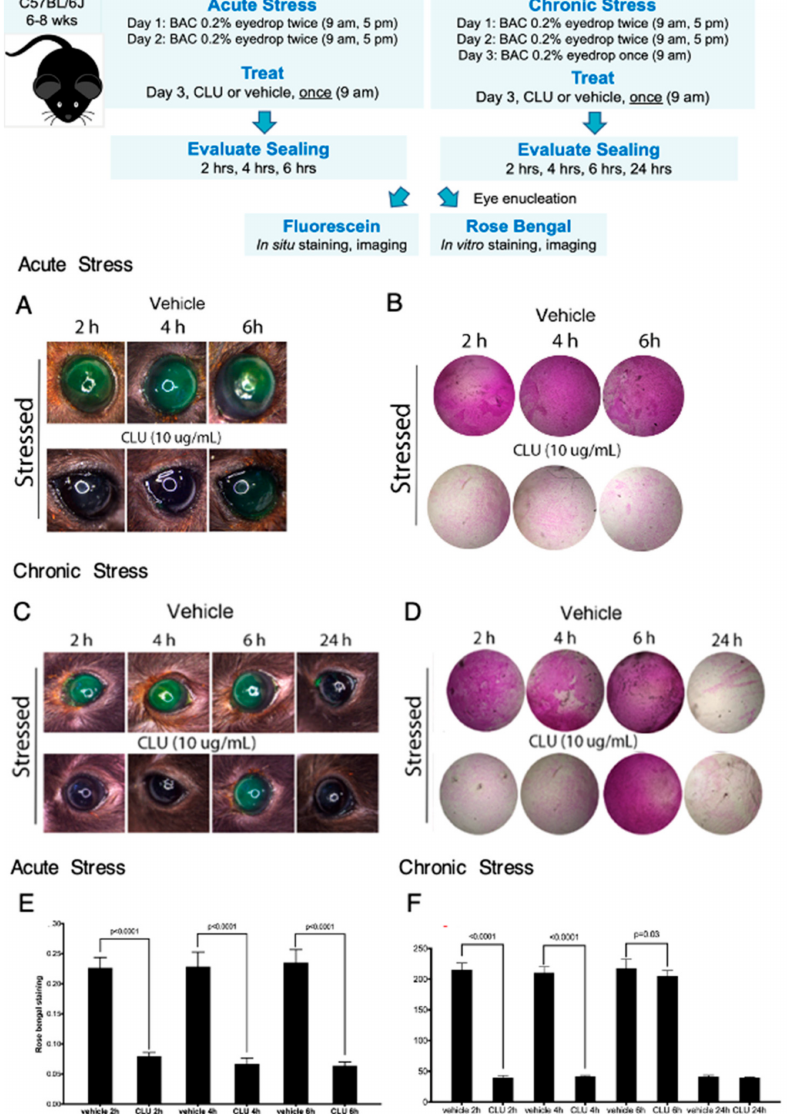
Figure 3. CLU sealing of the ocular surface barrier damaged by BAC persists for 4 to 6 h. Acute Stress. One drop of a BAC solution (0.2% dissolved in PBS) was applied to the ocular surface twice (9 a.m., 5 p.m.) on day 1, and twice (9 a.m., 5 p.m.) on day 2. On the morning of day 3, the ocular surface was treated topically with CLU (10 µ g/mL) or PBS vehicle alone. Sealing was then assayed every two hours subsequently, for 6 h total. Shown are representative eyes stained with ( A ) fluorescein, or ( B ) rose bengal. Chronic Stress. One drop of a BAC solution (0.2% dissolved in PBS) was applied to the ocular surface twice (9 a.m., 5 p.m.) on day 1, and twice (9 a.m., 5 p.m.) on day 2. On the morning of day 3, BAC was applied one more time, then the ocular surface was treated topically with CLU (10 µ g/mL) or PBS vehicle alone. Sealing was assayed every two hours subsequently for 6 h, then at 24 h. Shown are representative eyes stained with ( C ) fluorescein, or ( D ) rose bengal. Quantification. Rose bengal staining in ( E ) acute stress and ( F ) chronic stress experiments is quantified and expressed on the graphs shown as the mean ± SD ( n = 3). Statistical significance was determined by paired T -test and p -values are indicated over the lines connecting bars which are significantly